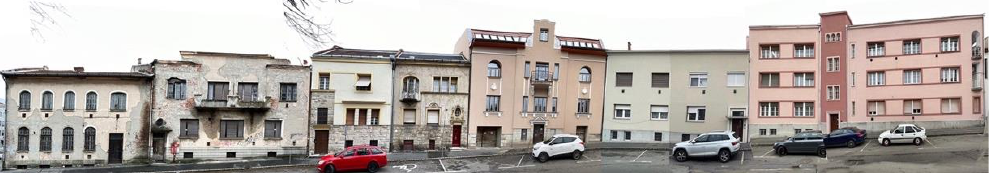
Figure 6. The eastern side of the Guszt á v Csengey street. The building by Victor Bohm is the second to the left. Source: Lovra